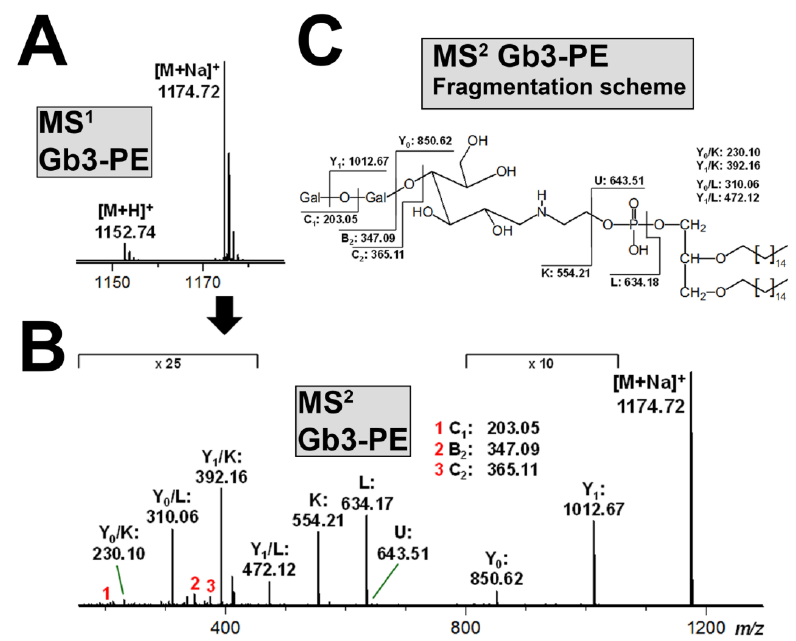
Figure 7. MS 1 spectrum ( A ) and MS 2 structural proof ( B ) with corresponding fragmentation scheme ( C ) of the produced neoglycolipid Gb3-PE. MS analysis using the positive ion mode exhibits dominance of monosodiated [M + Na] + ions over the protonated [M + H] + ion species ( A ). The [M + Na] + ions at m / z 1174.72 were selected for MS 2 analysis ( B) and the obtained breakdown products are explained by the auxiliary fragmentation scheme ( C ). Microorganisms 2019 , 7 , x FOR PEER REVIEW